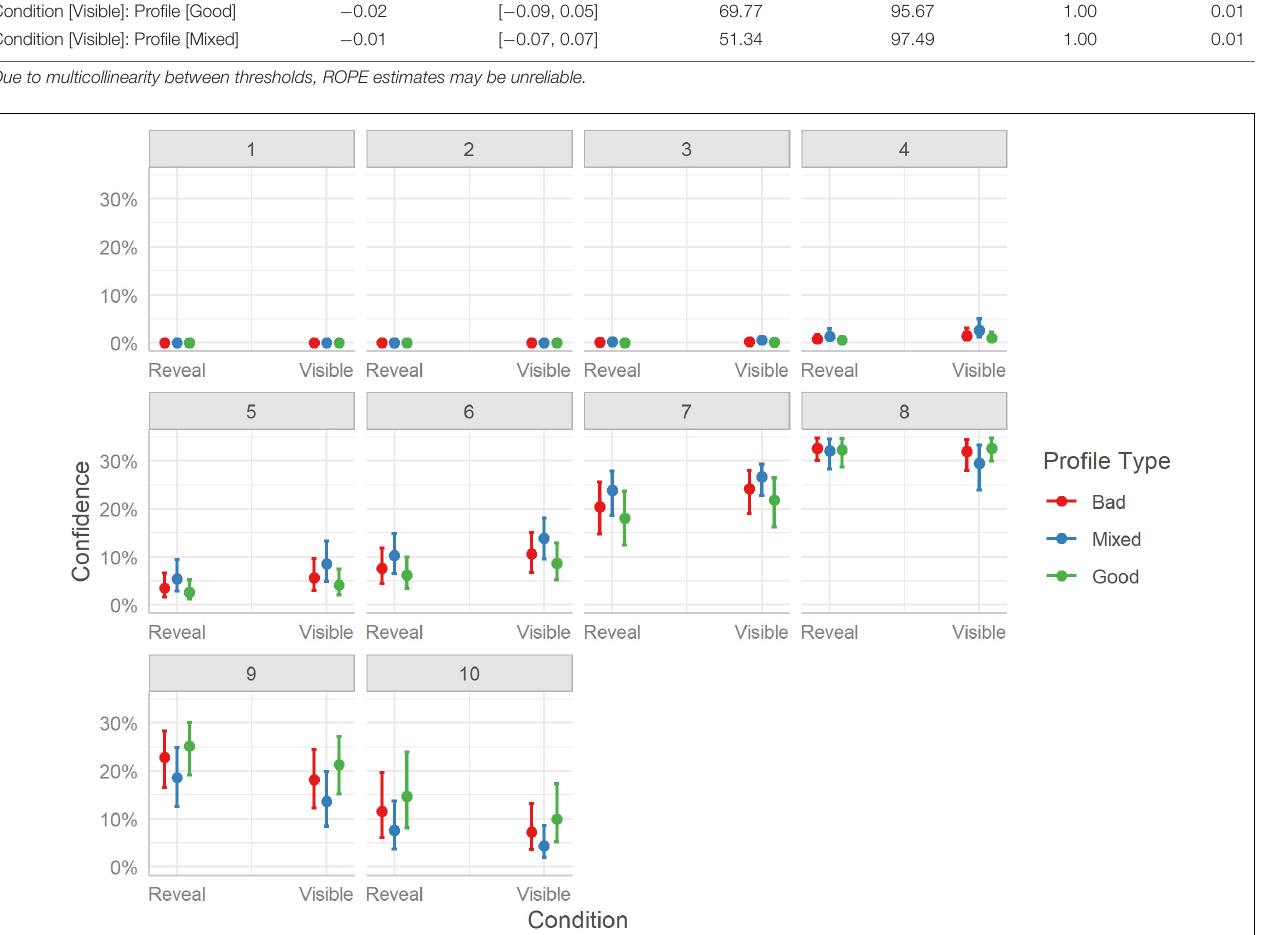
Considering the difference in sociability ratings as a single relation effect we find that users rated hosts of Bad profiles lower than both hosts of Mixed, Mdn = −